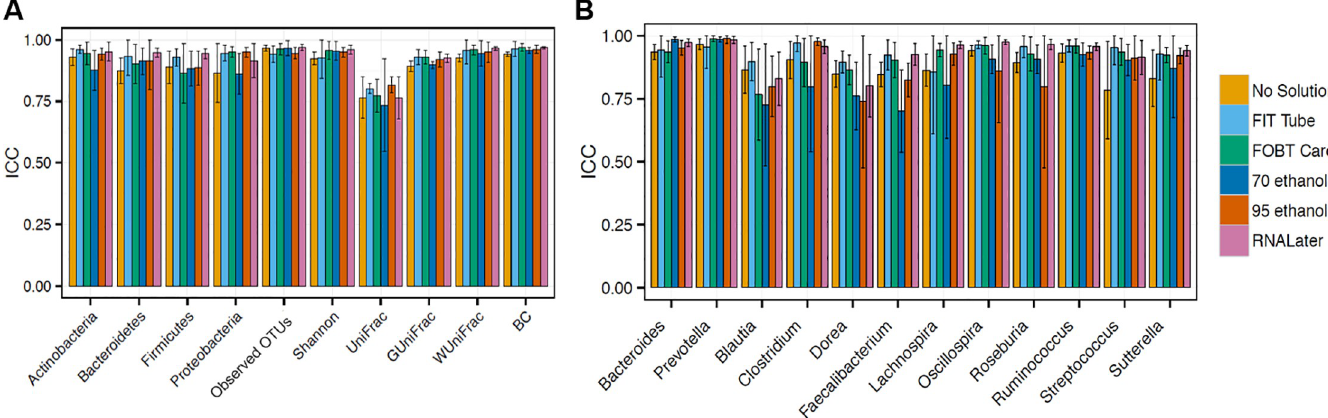
Fig 1. Meta-analyzed ICCs based on a random effects model for technical reproducibility comparing duplicate samples frozen day-0 from fecal samples collected using six different methods among 132 participants in five studies (Mayo 1-Knight lab, Mayo 1-Mayo lab, Mayo 2, Bangladesh, and Colorado). ICCs are based on ten microbial composition metrics (panel A; square root transformed abundance of four phyla, two alpha diversity metrics [number of observed OTUs and Shannon index] and four beta diversity metrics [unweighted UniFrac, generalized UniFrac, weighted UniFrac, and Bray-Curtis distance]), and square root transformed select bacterial genera (panel B) with prevalence in the population > 80% and a mean relative abundance > 0.2%. Error bars represent 95% CIs. Abbreviations : BC , Bray-Curtis distance; FIT , fecal immunochemical test tubes; FOBT , fecal occult blood test cards; FTA , Flinders Technology Associates cards; GUniFrac , generalized UniFrac distance; ICC , intraclass correlation coefficient; UniFrac , unweighted UniFrac distance; WUnifrac , weighted UniFrac distance .